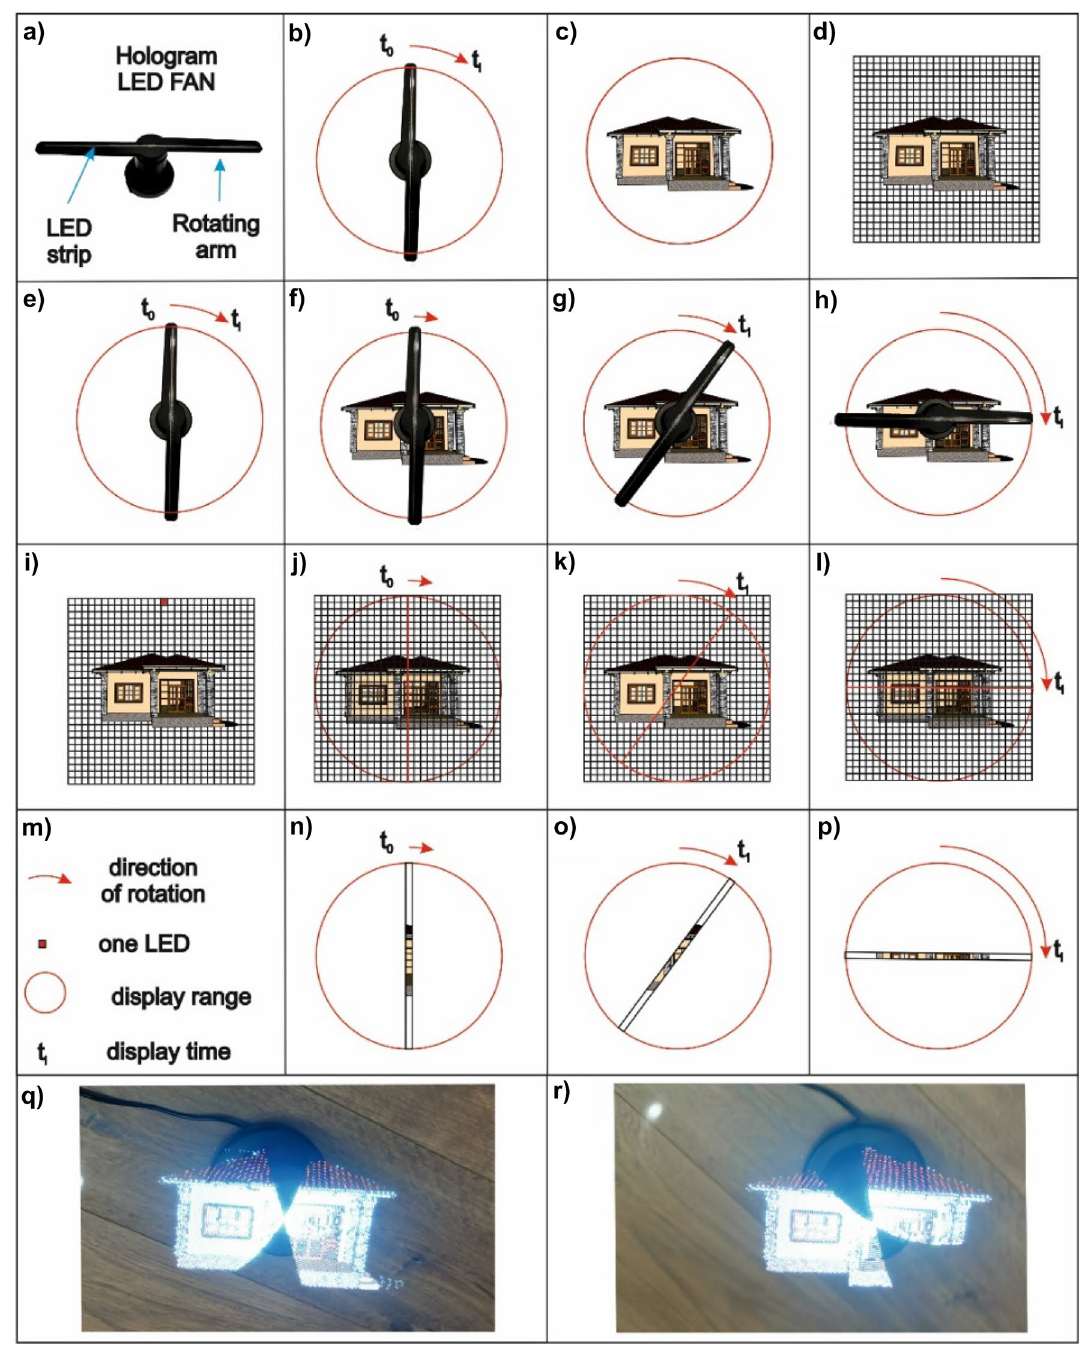
Figure 6. Visualisation of a single-family house in an LED FAN hologram: ( a ) LED FAN hologram; ( b ) direction of the arm’s rotation; ( c ) object display area; ( d ) the object being displayed with a network of squares; ( e–h ) animation of movement depending on the observation epoch; ( i–l ) object display logic; ( m ) legend; ( n–p ) single LEDs with different colours displayed; ( q,r ) different visualisation epochs. Source own